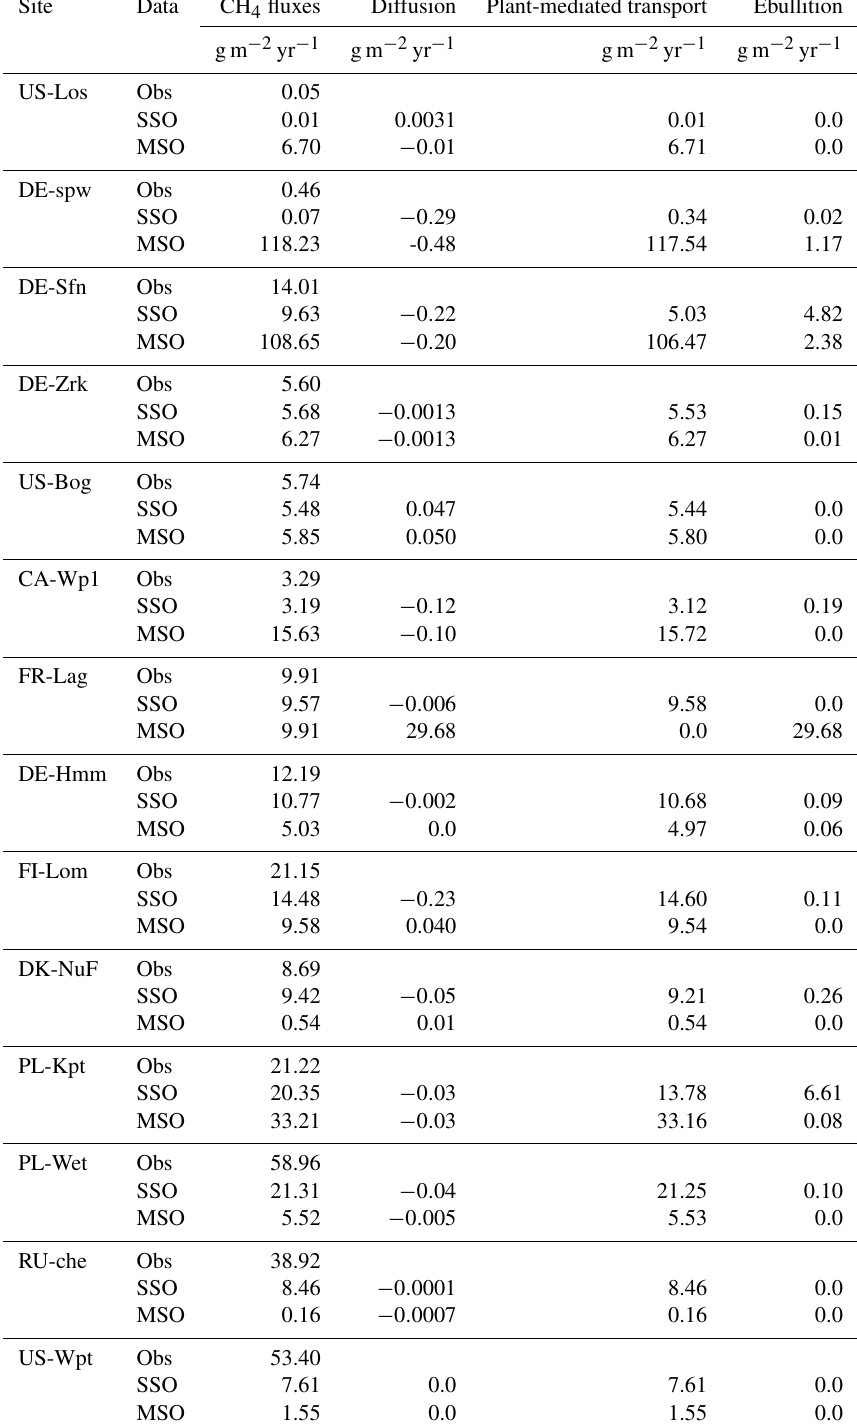
Table 9. Yearly methane emissions defined from the observed data (Obs) as well as simulations employing optimized parameters obtained by the single site optimization (SSO) and multi-site optimization (MSO). The methane fluxes combine methane emitted by diffusion, plant- mediated transport, and